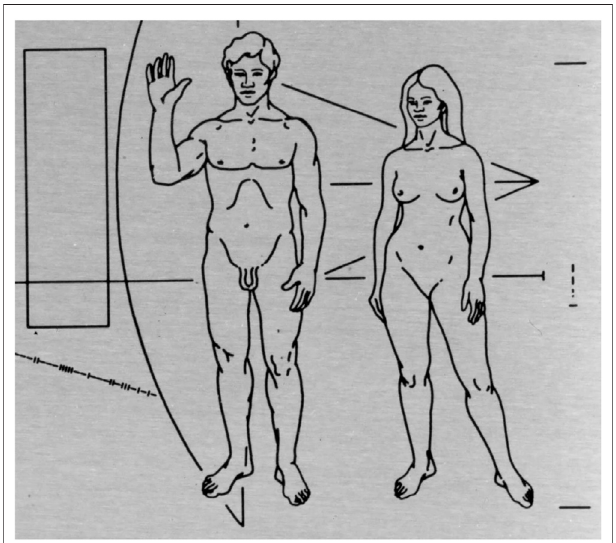
FIGURE 11 | The detail of Pioneer Plaque, the greeting couple of Earthlings. Credit: NASA.